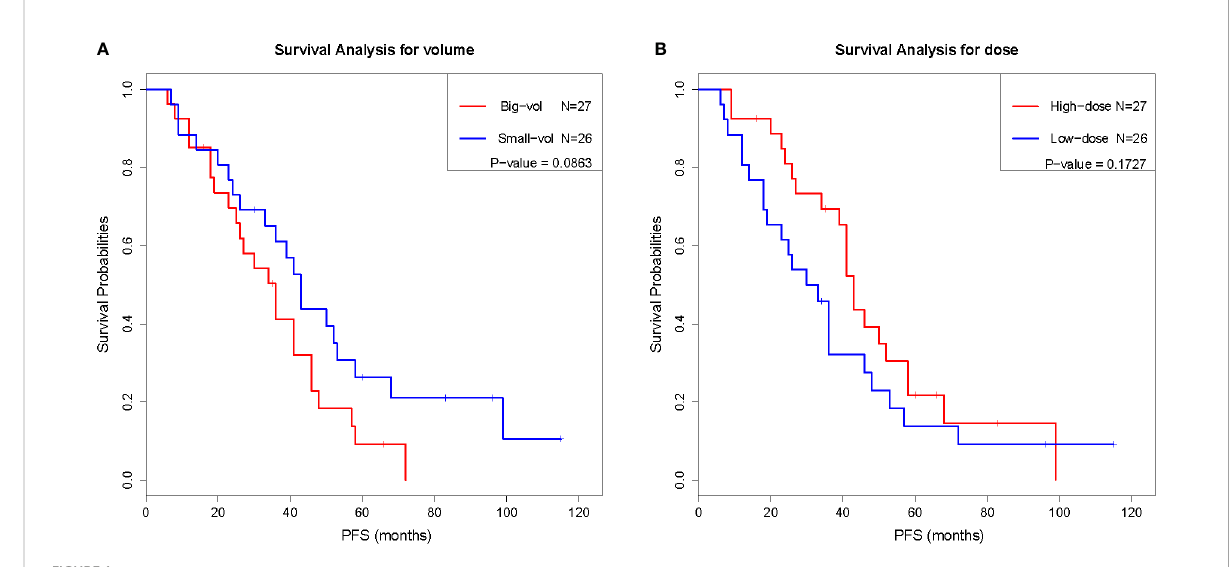
FIGURE 1 Kaplan-Meier analysis of tumor volume (A) and peripheral dose (B)